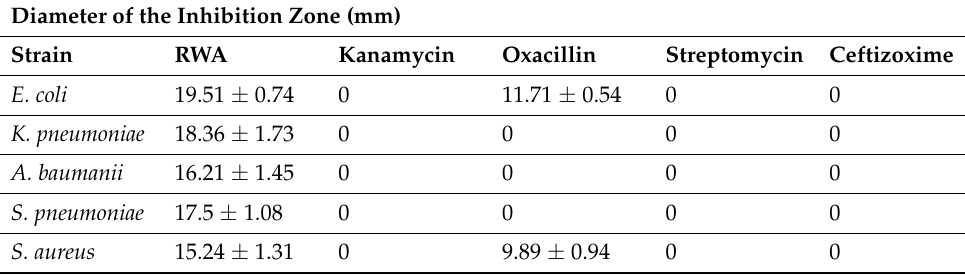
Table 3. Inhibition diameters of RWA tested against bacterial strains. Diameter of the Inhibition Zone (mm) Strain RWA Kanamycin Oxacillin Streptomycin Ceftizoxime E. coli 19.51 ± 0.74 K. pneumoniae 18.36 ± 1.73